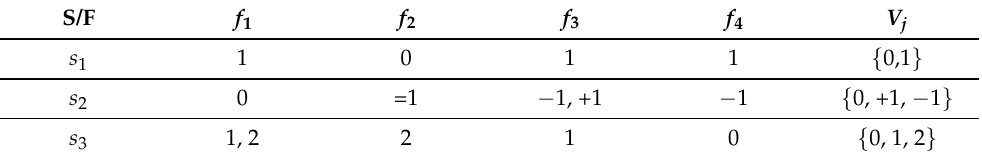
Table 2. Example FIS